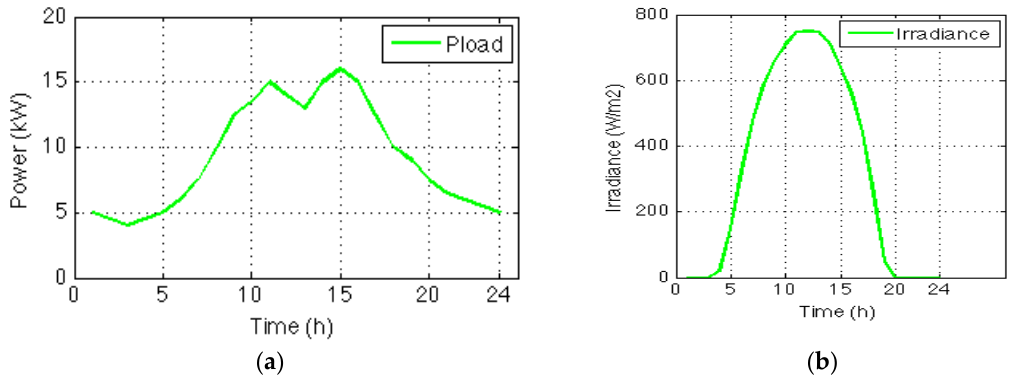
Figure 9. ( a ) Daily typical load curve of an office; ( b ) Daily typical irradiance.